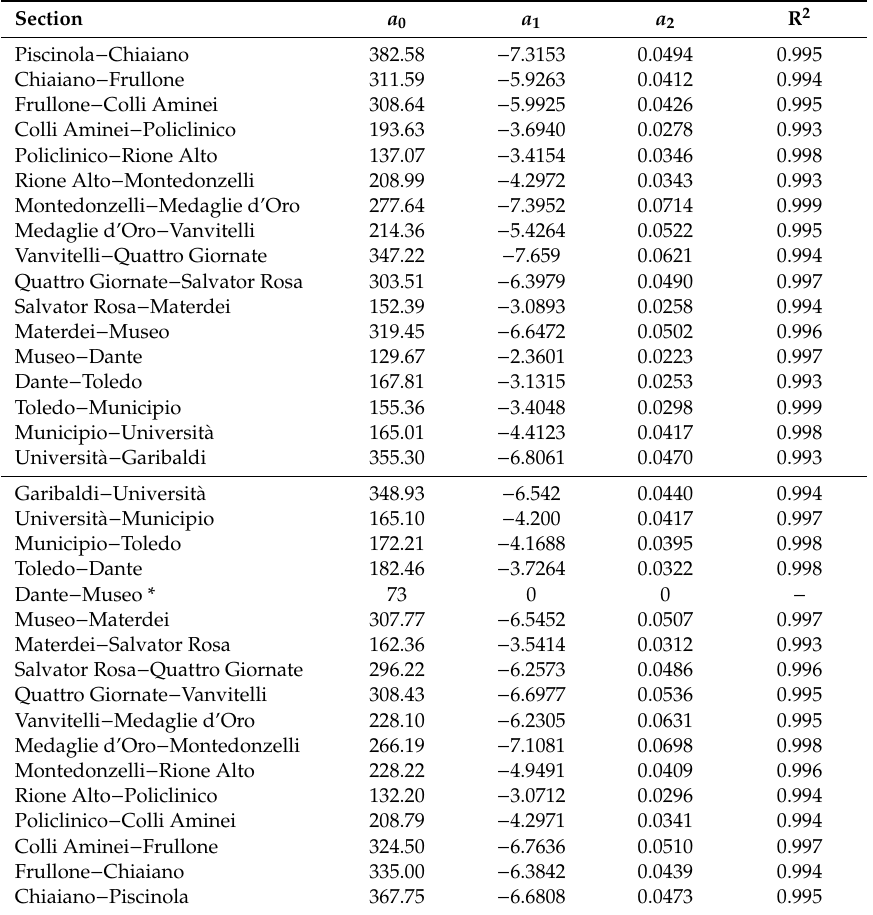
Table 1. Coe ffi cients of Equation (5) for each section.